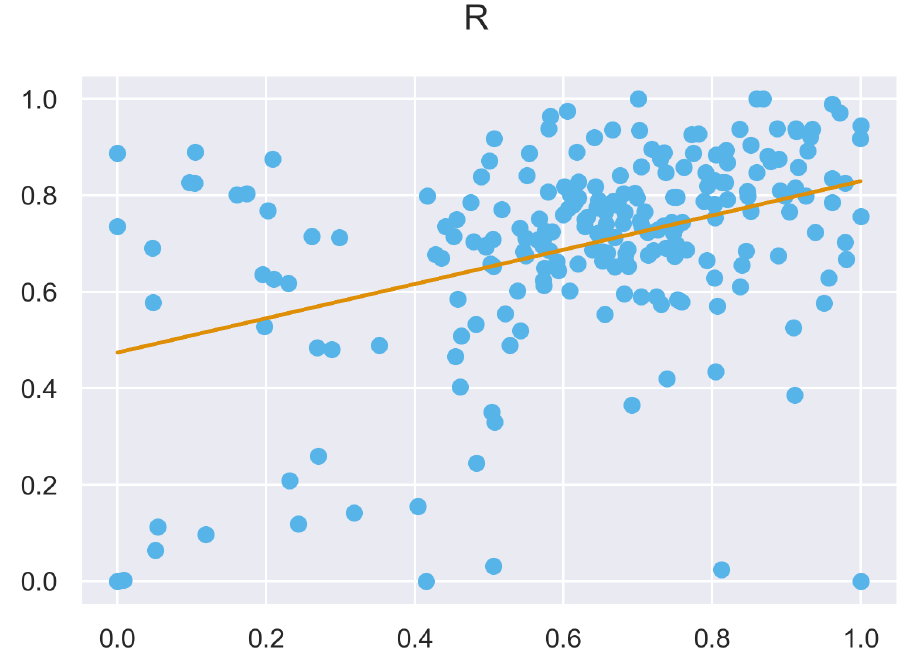
Figure A51. ULS and TLS R regression at 5m grid size.